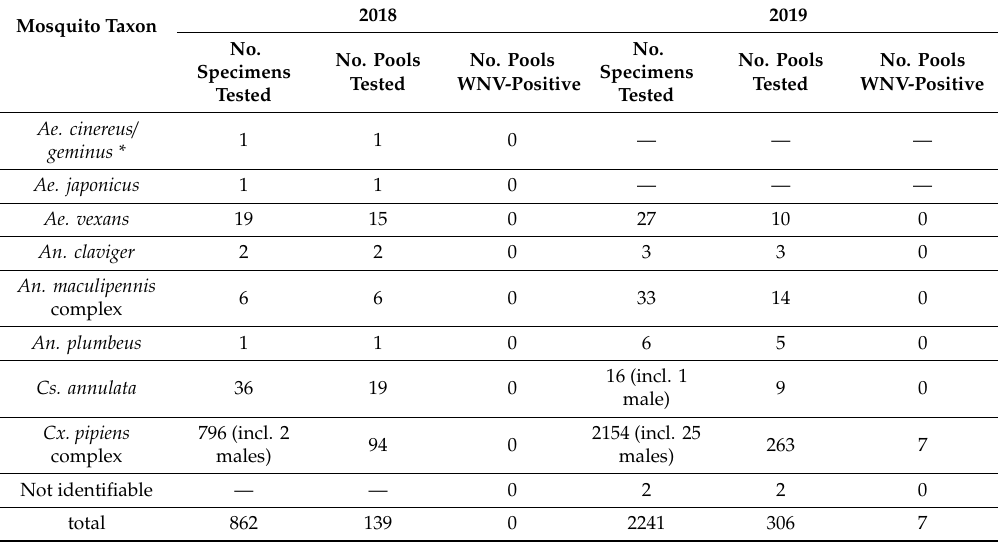
Table 1. Mosquitoes collected at the four collection sites in 2018 and